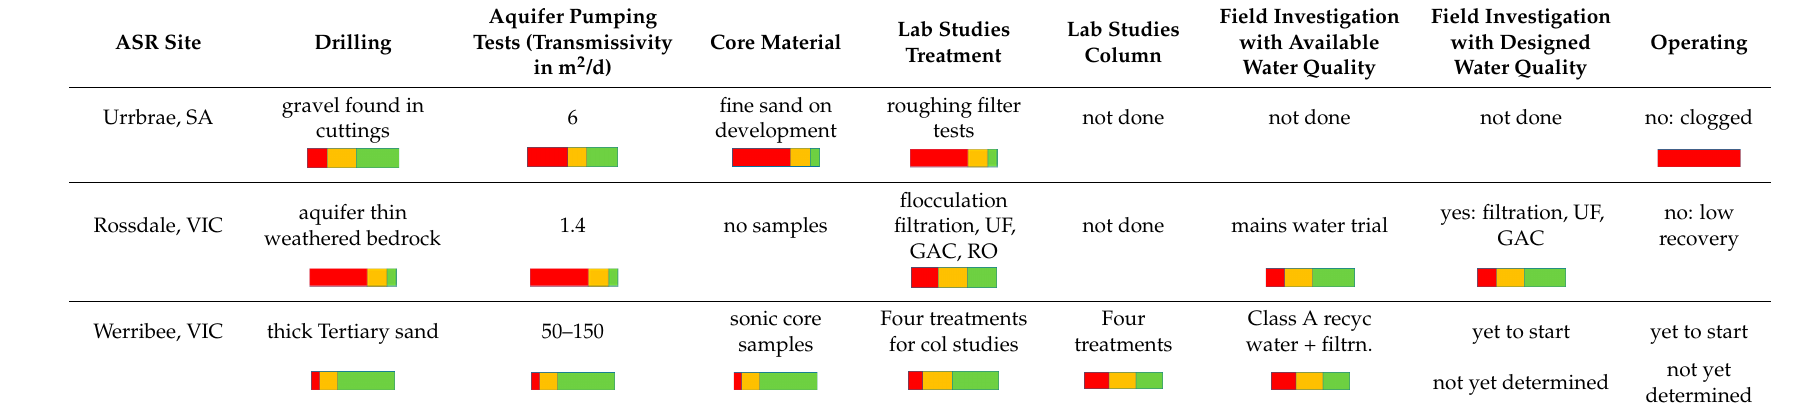
Table 1. Investigations informing assessment of clogging at field ASR sites. Probability of economic management of clogging for an ASR operation at this site that is inferred by each stage of investigations is shown in a bar graph. Here, green represents the perceived likelihood of successful management, amber represents unknown likelihood, and red indicates the likelihood of unsuccessful management (i.e., uneconomic management of clogging).